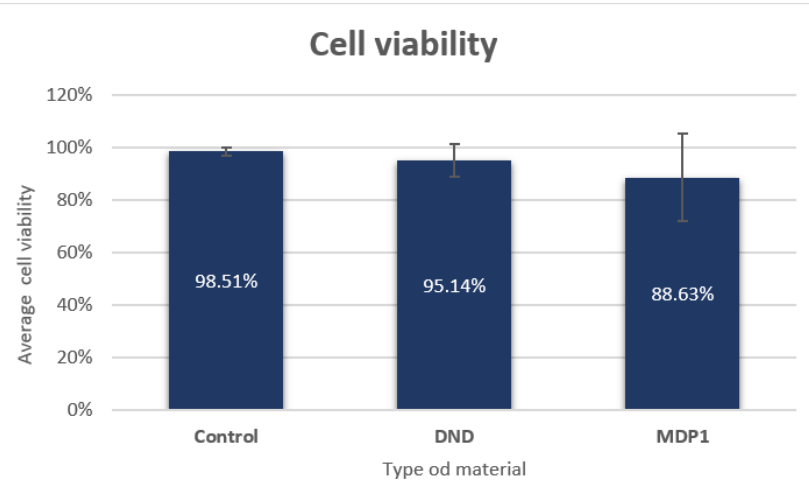
Figure 2. Cell viability in the presence of diamond nanoparticles .